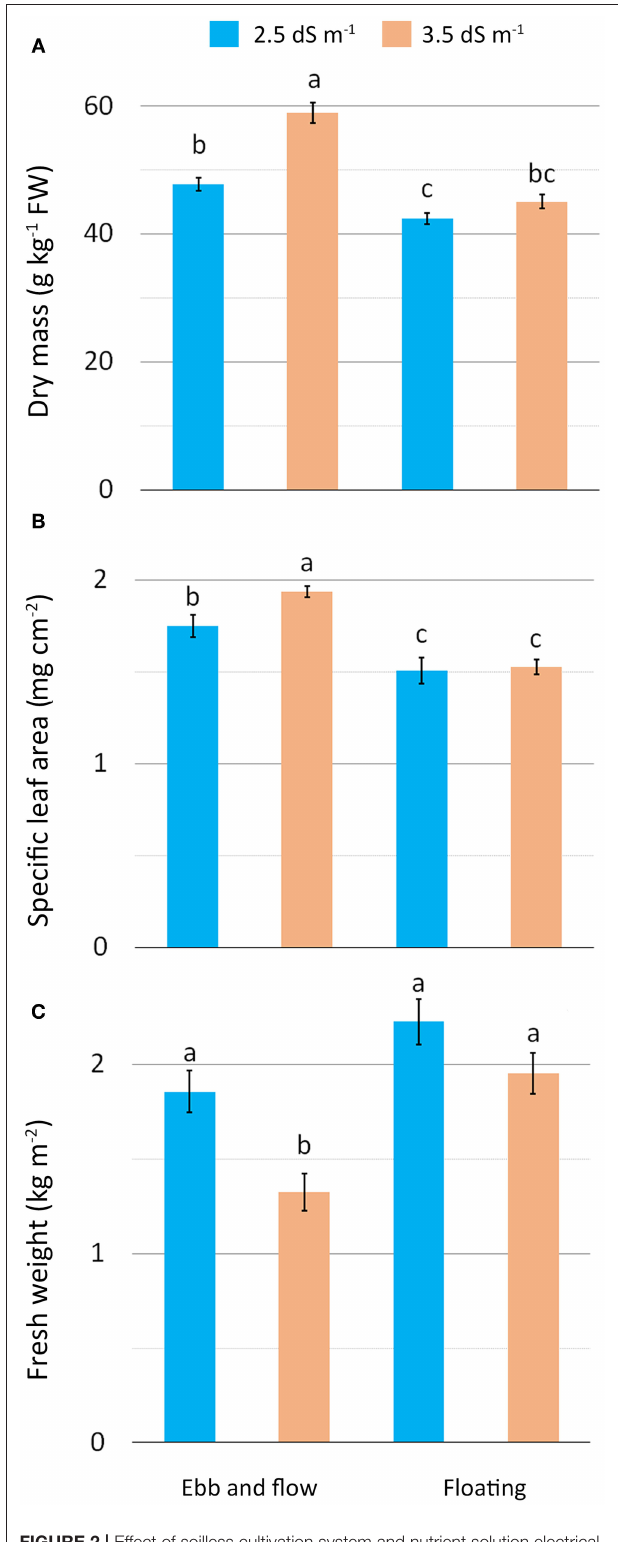
FIGURE 2 | Effect of soilless cultivation system and nutrient solution electrical conductivity on dry mass (A) , specific leaf area (B) and yield (C) of romaine lettuce grown in a greenhouse during the autumn. Vertical bars indicate ± SE of mean ( n = 9) of the observed values, with different letters significantly different according to the LSD test ( α =